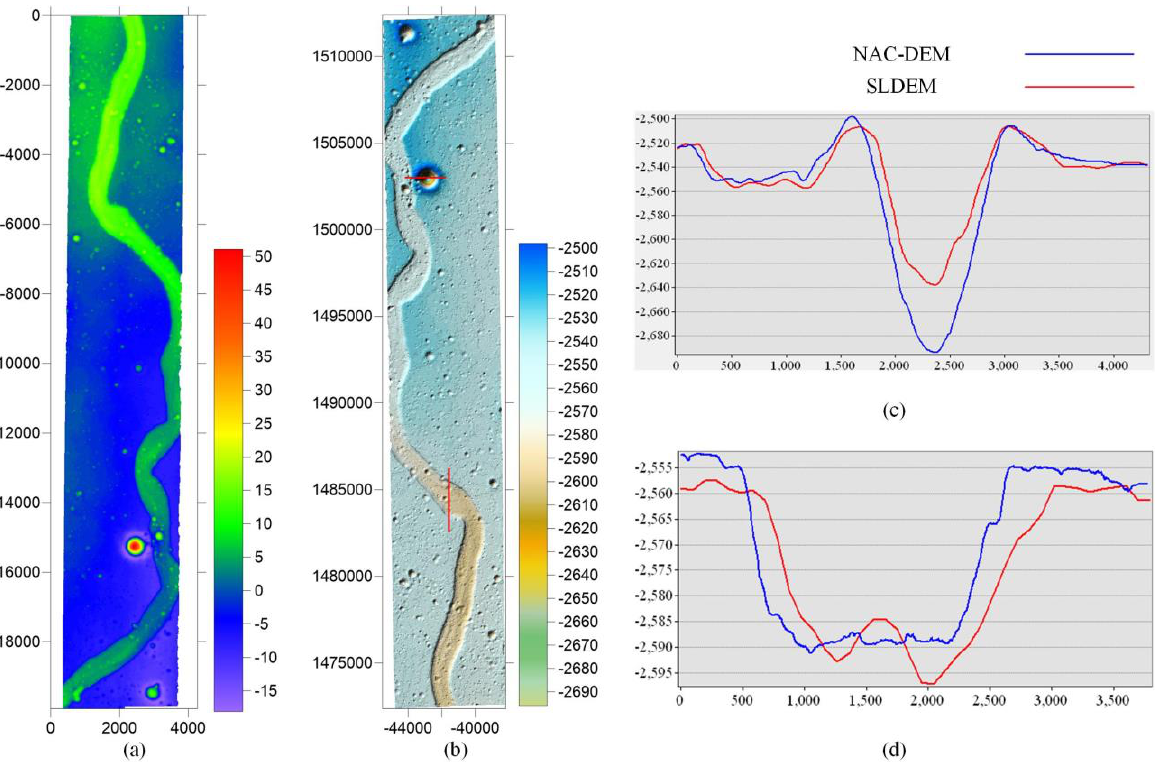
Figure 6. Disparity map and DEM of the stereo pair. (a) Disparity map of the coupled rectification images; (b) shaded relief map of the DEM, the elevation is exaggerated for 5 times to better reveal the terrain surface; (c) and (d) profiles comparisons of the horizontal and vertical red lines in (b), respectively, between the SLDEM and